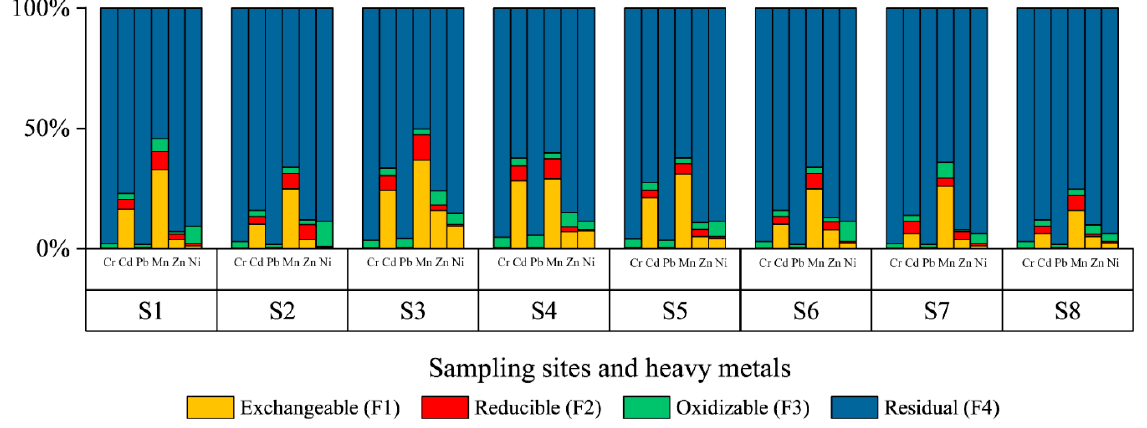
Figure 7. Percentage of each speciation for heavy metals in study area.